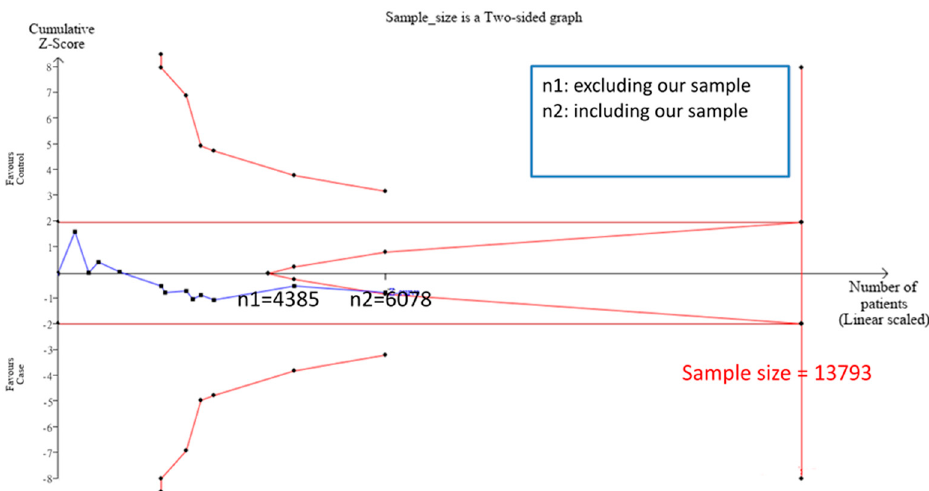
Figure 2. Trial sequential analysis (TSA) used in this meta-analysis for the Asian sample. TSA is a methodology that includes a sample size calculation for a meta-analysis with the threshold of statistical significance. TSA was performed using an allele model assumption but replacing the allele count with the sample size (divided by 2). Detailed settings: Significance level = 0.05; power = 0.80; ratio of controls to cases = 1; hypothetical proportion of D allele in control = 0.03; least extreme OR to be detected = 0.67; I 2 (heterogeneity) = 71%.